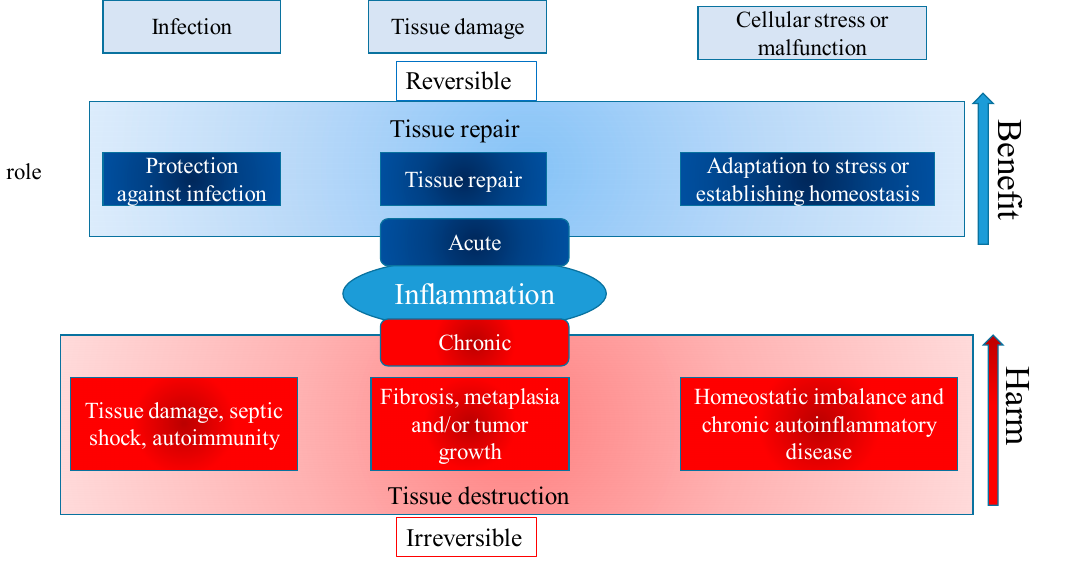
Figure 1. Inflammatory reaction: physiological and pathological consequences of inflammation.